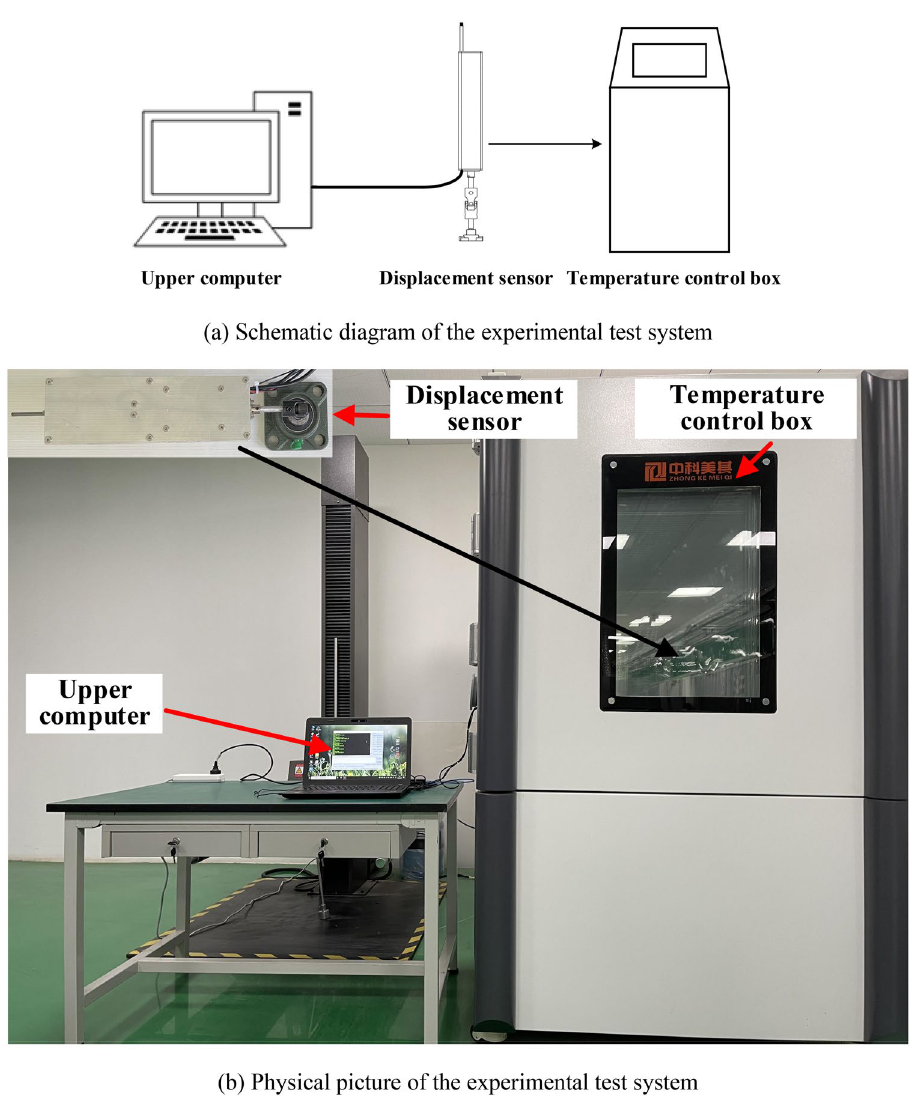
Figure 12. Schematic diagram of the temperature experimental test system (( a , b )were generated by Microsoft Visio Professional 2016 (https:// www. micro soft. com/ zh- CN/ downl oad/ detai ls. aspx? id=